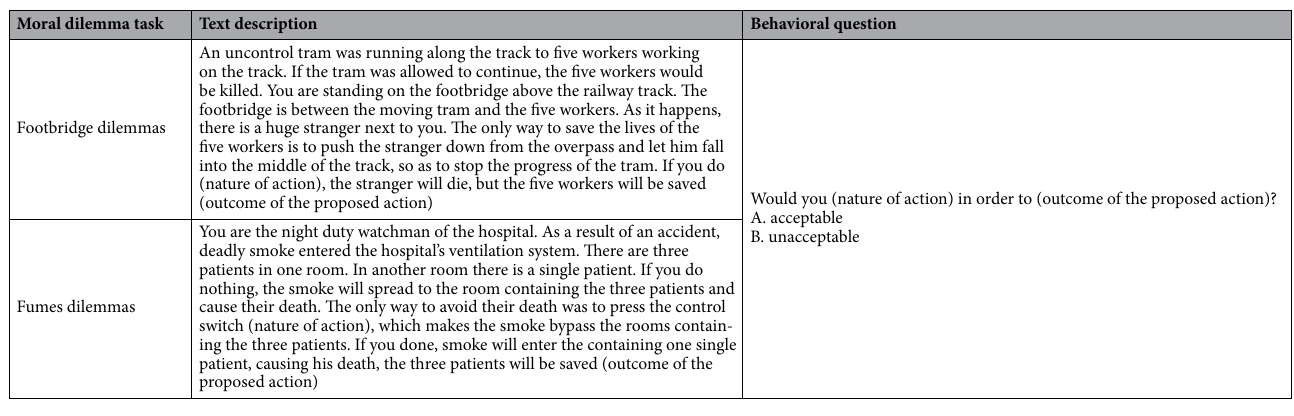
Table 1. The moral dilemma task with representative